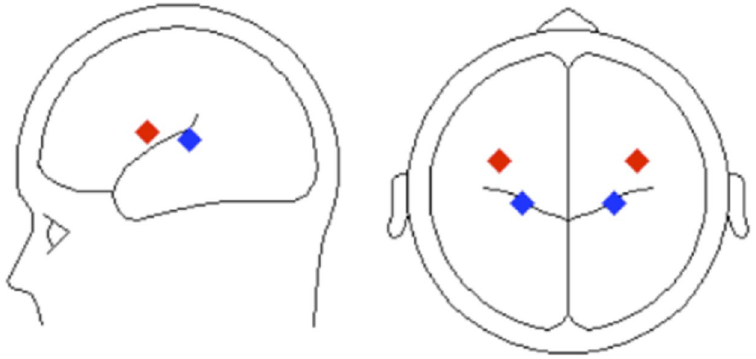
Figure 6. Dipole solution for distraction by location in the attend-frequency task (blue) (mean ± sem: x = 22.9 ± 1.9; y = − 25.3 ± 5.4; and z = 13.5 ± 3.0) and distraction by frequency in the attend-location task (red) (mean ± sem: x = 34.7 ± 1.9, y = 1.3 ± 3.9; z = 20.1 ±